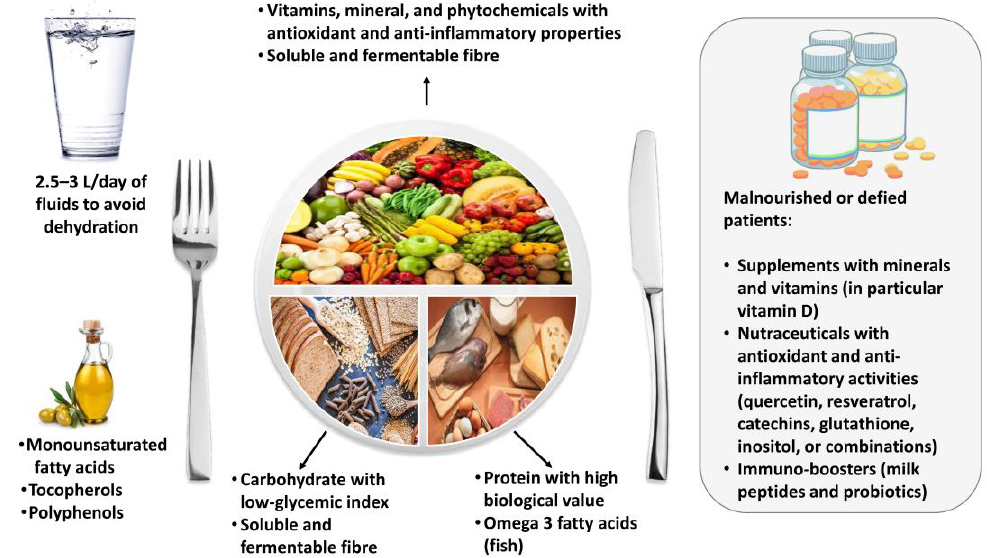
Figure 1. Dietary recommendations for patients with post-COVID-19 syndrome.